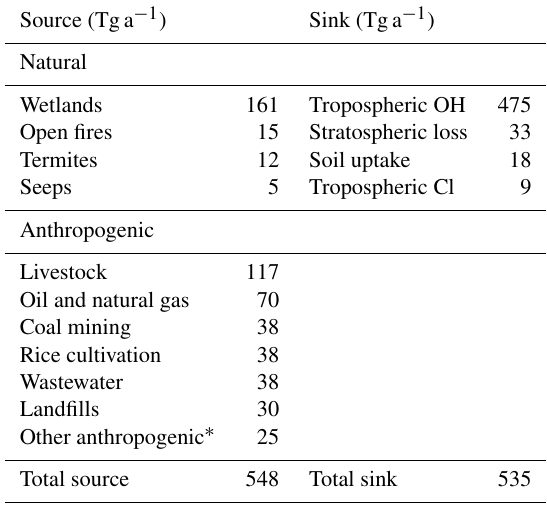
Table 1. Prior global estimates of methane sources and sinks